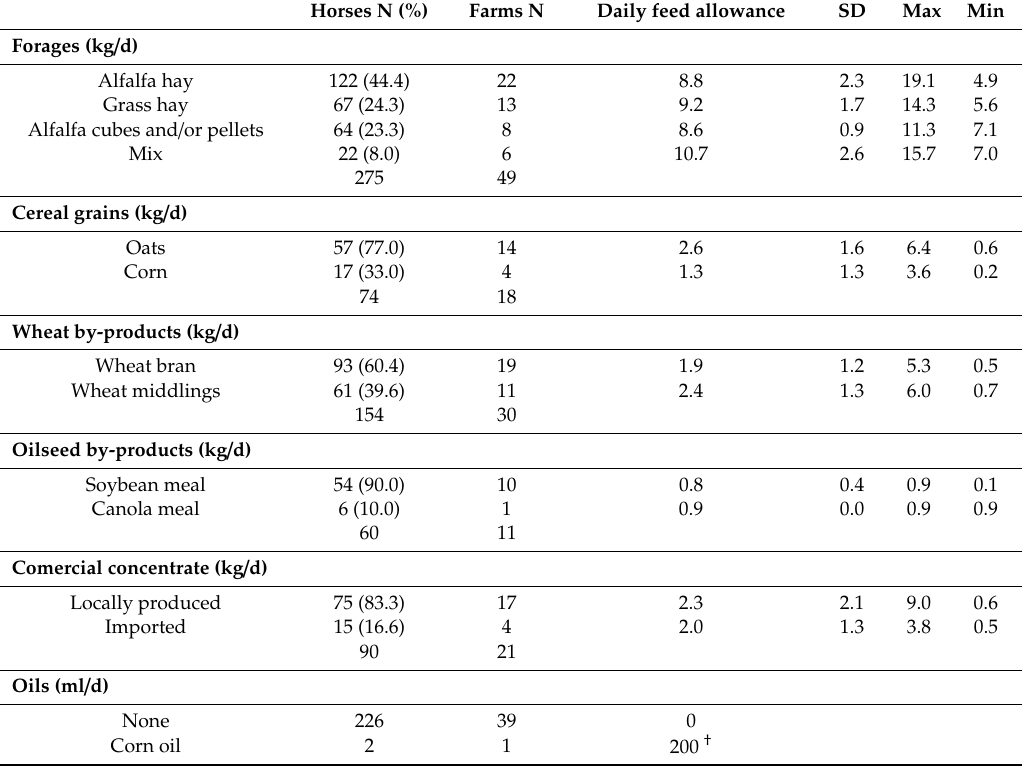
Table 4. Feedstu ff s by type and quantity that were o ff ered to every horse on a daily basis, as